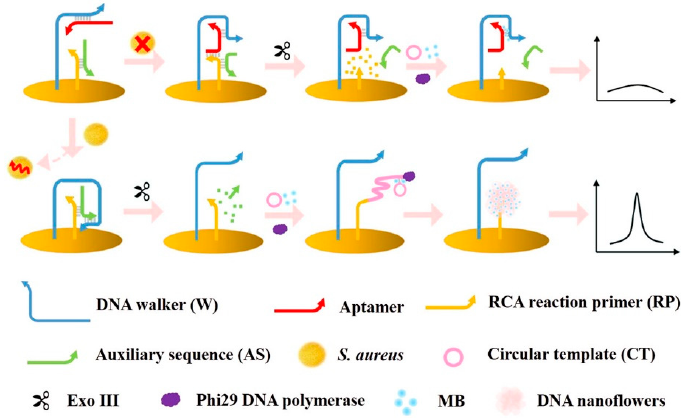
Figure 7. Schematic representation of the biosensor for S. aureus based on a DNA walker and DNA nanoflowers. Reprinted with permission from [126] Copyright 2021 American Chemical Society.